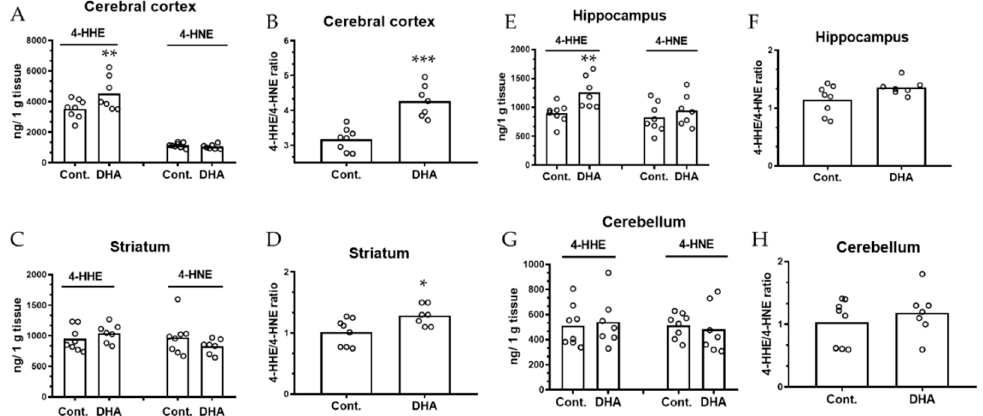
Figure 2. Maternal DHA intervention alters the levels of -hydroxyhexenal (4-HHE) and 4-hydroxynonenal (4-HNE) and 4-HHE/4-HNE ratios in offspring brain regions. ( A , C , E , G ): Levels of 4-HHE and 4-HNE in different brain regions (cortex, striatum, hippocampus, and cerebellum, respectively) from pups nursed by control and 1% DHA mothers. ( B , D , F , H ): Ratios of 4-HHE/4-HNE in different brain regions (cortex, striatum, hippocampus, and cerebellum, respectively). Levels of 4-HHE and 4-HNE in brain regions were measured using LC-MS/MS as described in text, and normalized to tissue weight. Each value represents the mean ± SEM of eight and seven pups from control and 1% DHA diet groups, respectively. Analysis using two-tail unpaired t-test indicated significance between DHA group and controls. * p < 0.05; ** p < 0.01; *** p < 0.001.